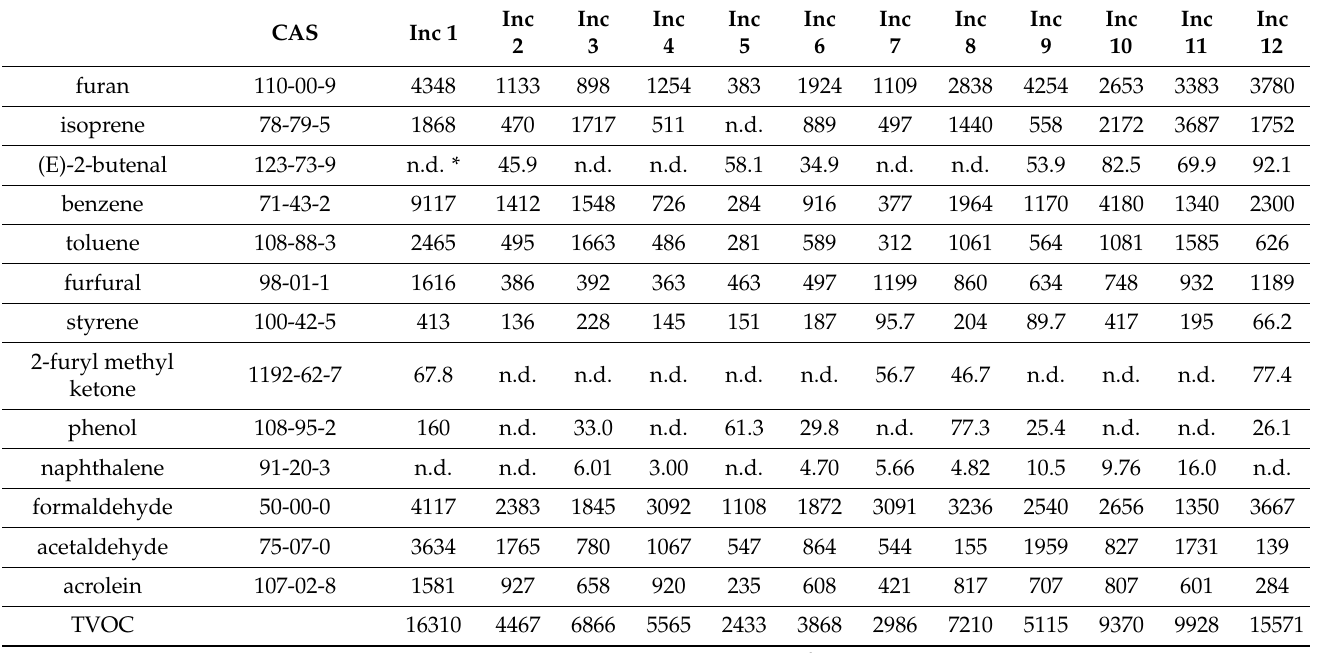
Table 4. Average emission factor ( µ g/h) values for TVOC, VOCs, and VVOCs selected in this study and observed in the test chamber for the twelve products tested.